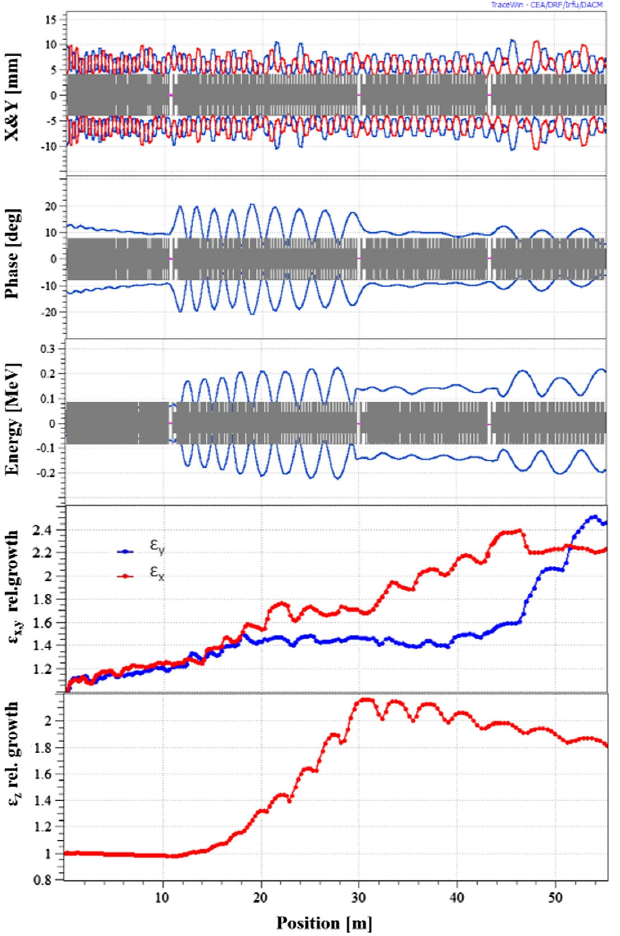
FIG. 11. Beam envelopes, transverse, and longitudinal rms- emittance growth for the complete DTL with intercavity sections and k 0 ;t ¼ 65 °, k 0 ;z ¼ 120 °.